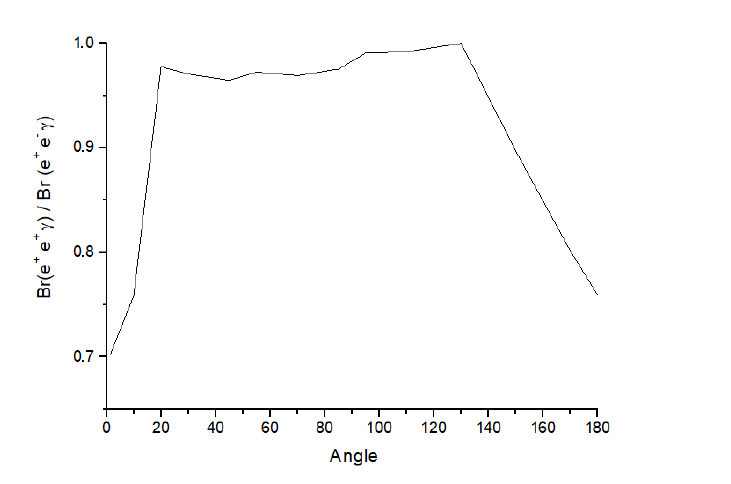
Figure 3. Dependence of Br ( e + e + γ ) / Br ( e + e − γ ) on the scattering angle between